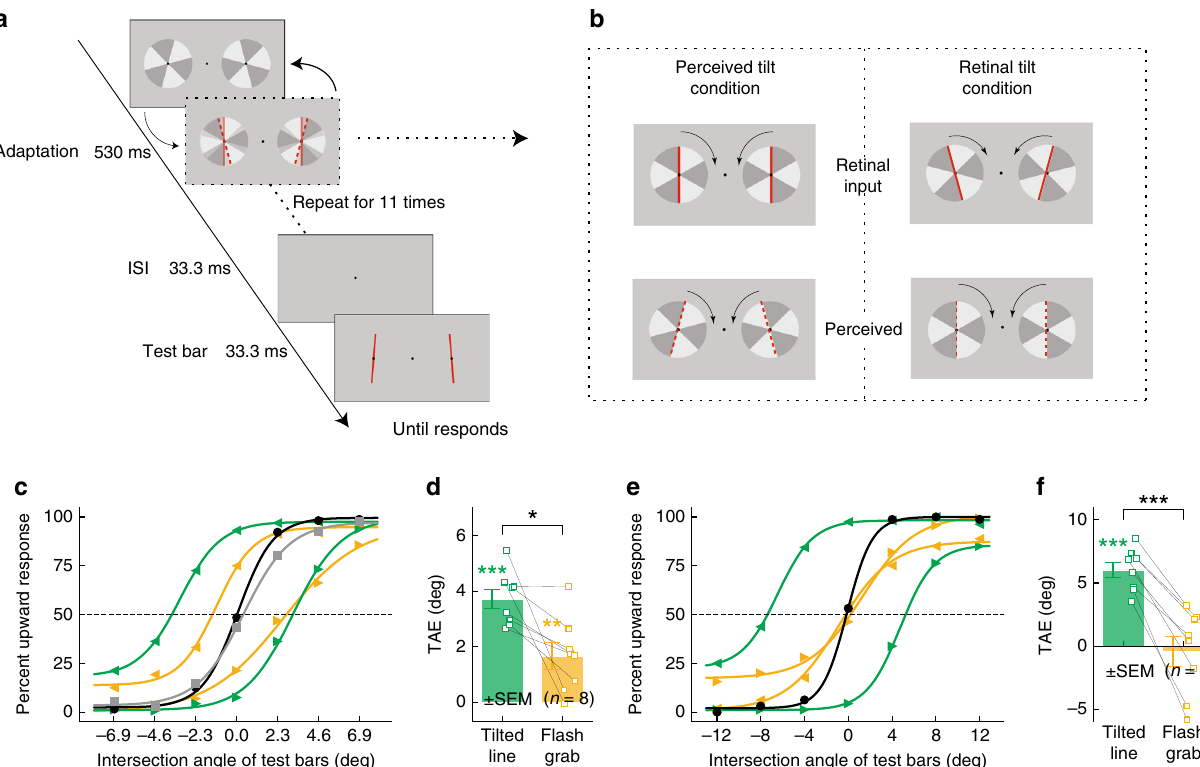
Fig. 1 Psychophysics stimuli and results. a Stimulus presentation sequence for the TAE measurement. b The stimuli used in the two orientation adaptation conditions and demonstrations of subjects ’ illusory perception. Left part: original vertical but perceived tilt with fl ash grab inducer (tilt angle is by 15.55° on average (SD = 7.54)). Right part: original tilt but perceived vertical with fl ash grab inducer. c Fitted psychometric functions using logistic regression in experiment 1, d Averaged TAE sizes across subjects ( n = 8) for conventional tilted bars condition ( p < 0.001 Holm-corrected) and fl ash grab condition ( p = 0.010 Holm corrected) in experiment 1 (two-sided paired t-test, p = 0.013, d = 1.17). e Fitted psychometric functions using logistic regression in experiment 2. f Averaged TAE sizes across subjects ( n = 8) for conventional tilted bars condition ( p < 0.001 Holm corrected) and fl ash grab condition ( p = 0.730 Holm corrected) in experiment 2 (two-sided paired t-test, p < 0.001, d = 2.80). Black curve: vertical bars only condition; gray curve: rotating background-only condition; green curves/bars: fl ashed tilted bars only condition (conventional tilt adaptation); orange curves/bars: fl ash grab